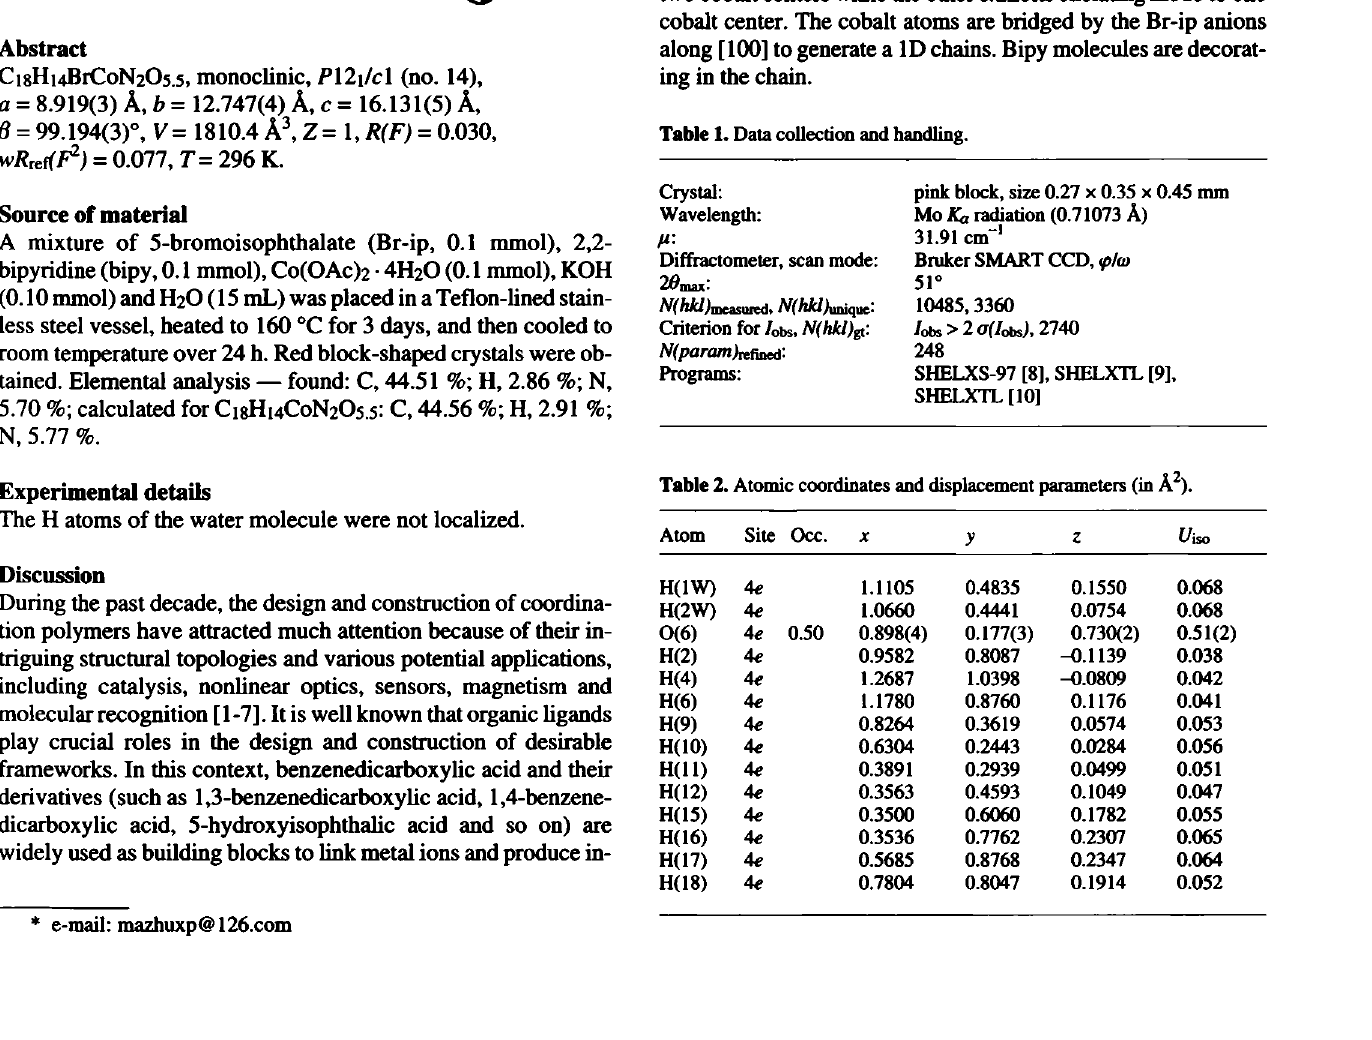
Table 1. Data collection and handling. Crystal: Wavelength: H- Diffractometer, scan mode: 20max: W Admeasured, APtylumque: Criterion for /obs, N(hkl)